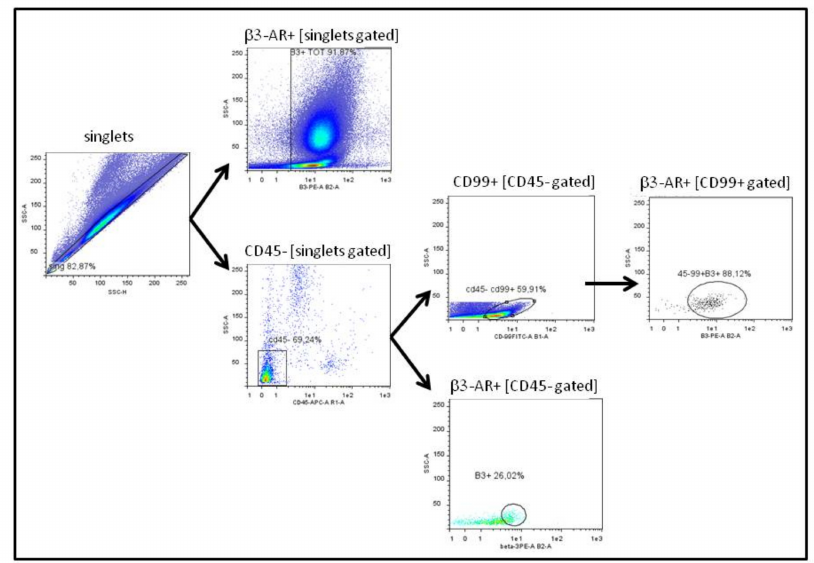
Figure 1. The figure represents the gating strategy used for the cytofluorimetric analysis of all